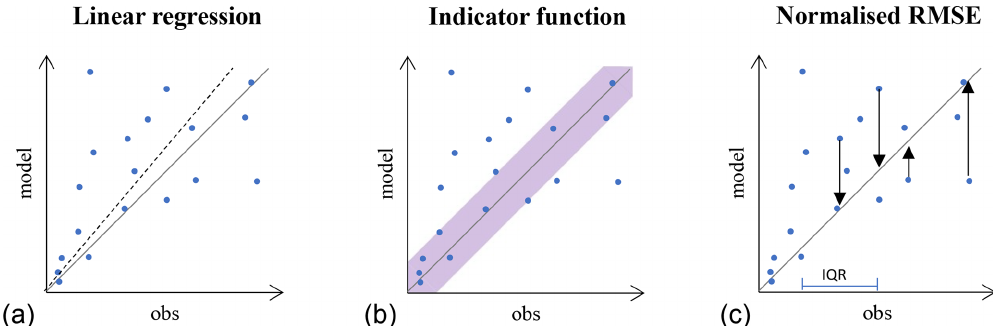
Figure 6. Three methods of statistical analyses of the true positive events, where both simulated and observed values are in the same (true positive) category. Linear regression (a) , an indicator function defined using an absolute scale (b) , and normalised root mean square errors (RMSEs) are shown (c) . The solid lines are the 1 : 1 lines, and the blue points are the calculated signatures for each event (modelled vs. observed